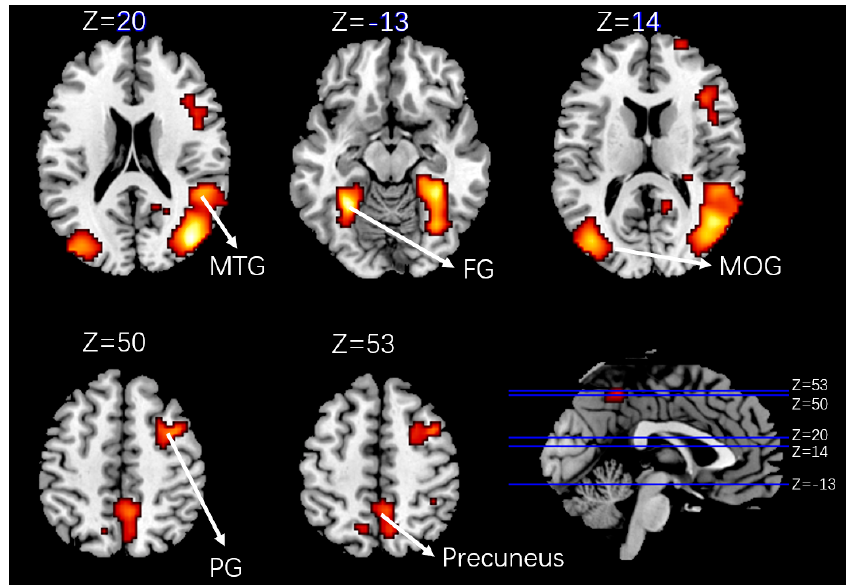
Figure 17. Activation brain area profile (MTG = Middle temporal gyrus; FG = Fusiform gyrus; MOG = Middle occipital gyrus; PG = precentral gyrus).